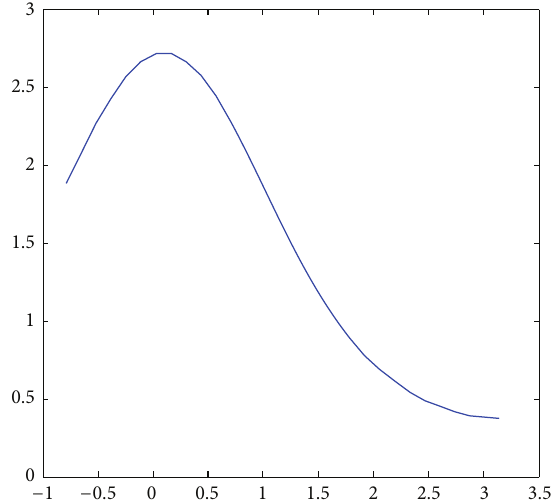
Figure 2: The numerical solution of (79a) and (79b) for (78) with ℎ = 0.1